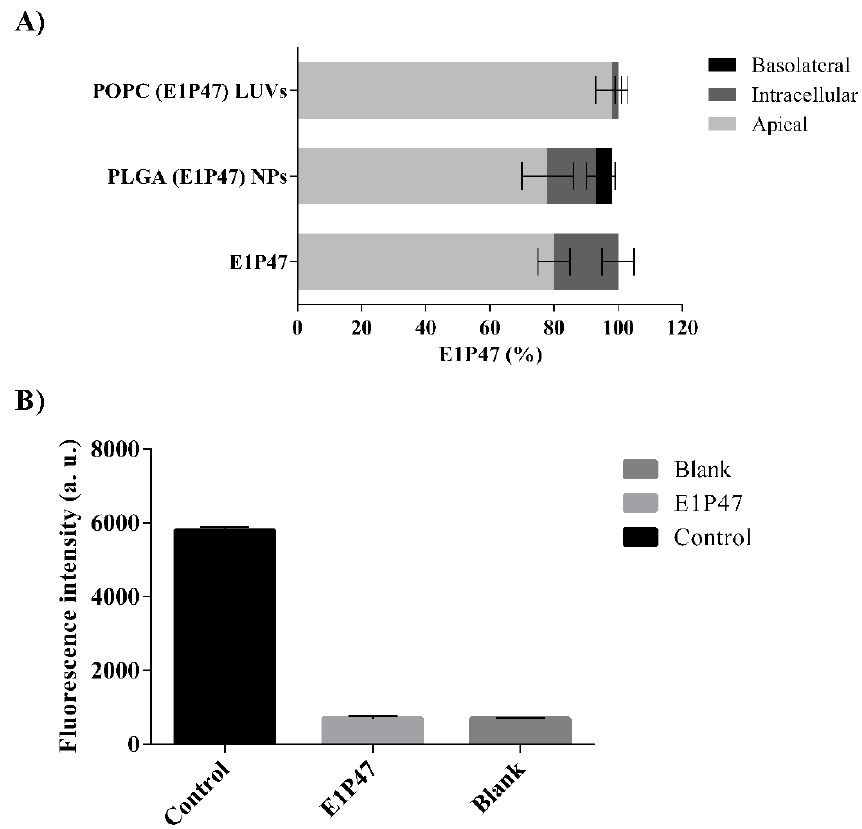
Figure 3. In vitro permeability assay in HEC-1A cells. ( A ) Percentage of E1P47 peptide quantified in each compartment of the Transwell system after treatment with POPC (E1P47) LUVs, PLGA (E1P47) NPs and E1P47, respectively; ( B ) Lucifer Yellow leakage through HEC-1A monolayer after treatment with E1P47 peptide and without the peptide (blank). The experiment was also carried without cell monolayer (control) to obtain the total leakage of Lucifer Yellow thorough the Transwell membrane inserts.